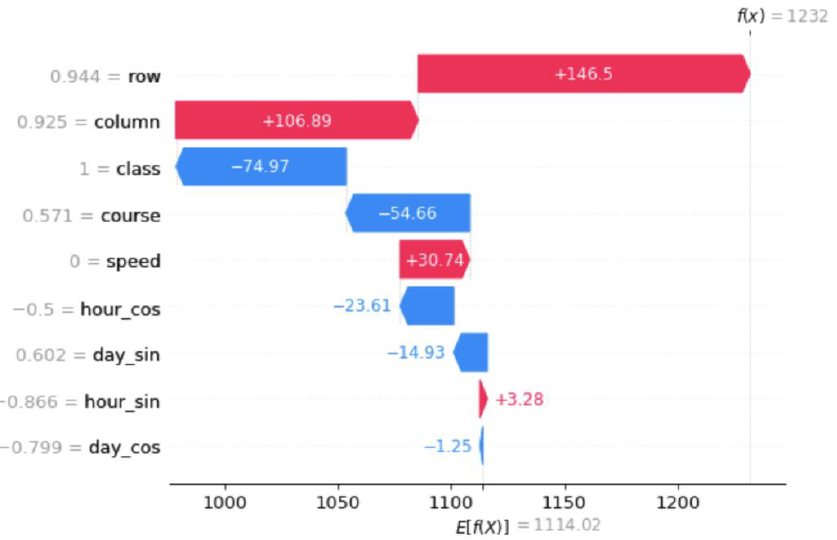
Figure 9. The contribution of each input feature to build the output predicted by KNN for ship 81.